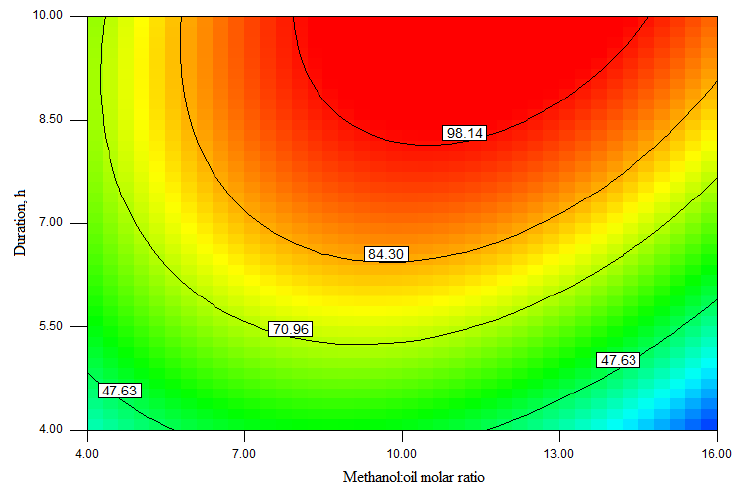
Figure 2. Response surface contour plot for the interaction between the process duration and the methanol-to-oil molar ratio for the ester yield (the catalyst amount is 7 wt%).